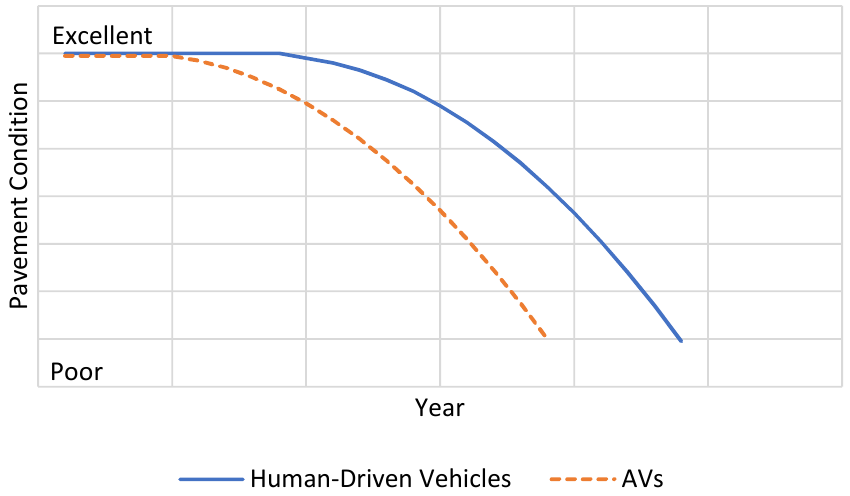
Figure 13. Change in pavement conditions over years for human-driven vehicles and AVs with zero wander.